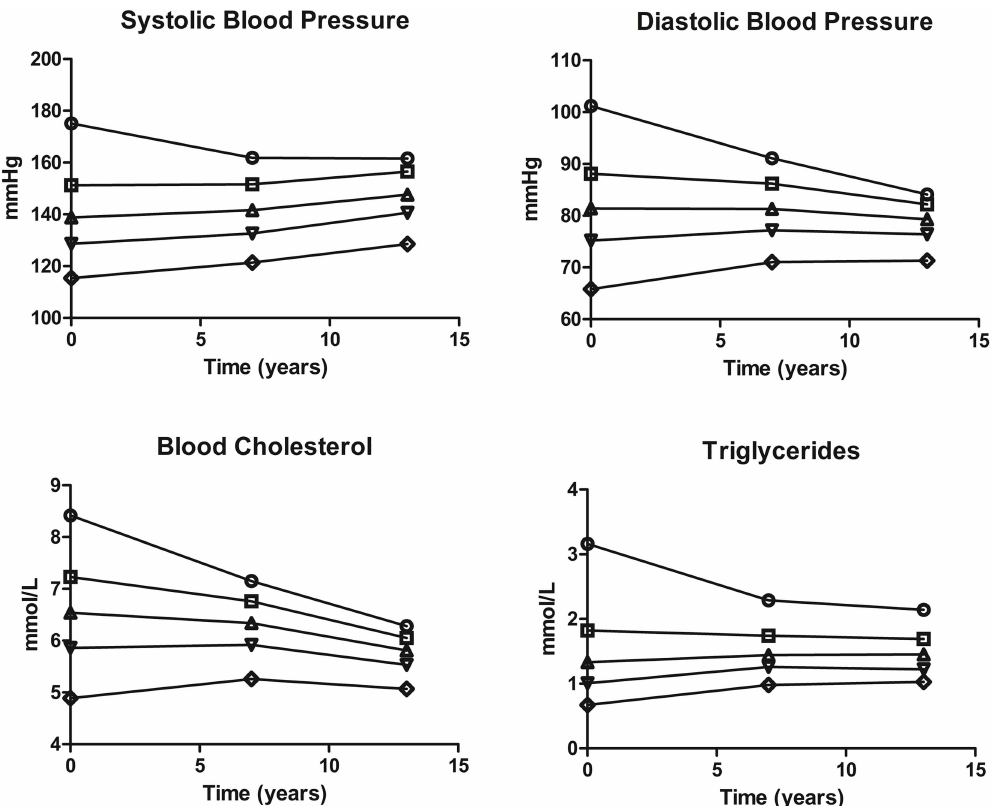
Fig 2. Intra-individualvariabilityover time. Subjects were divided into quintilesat baseline in Troms ø 4 accordingto their baselinevalue of a certainriskfactor. The mean value in each group is represented in the figure. Values were updatedafterapproximately 7 and 13 years, in Troms ø 5 and Troms ø 6, respectively.